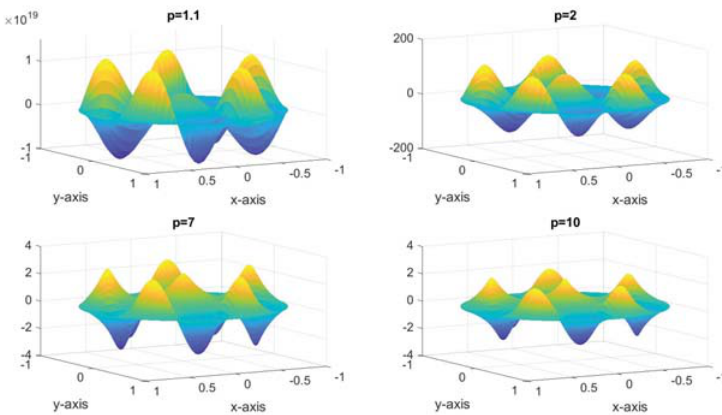
Fig. 11: Numerical solutions with six nodal regions and 5-symmetry